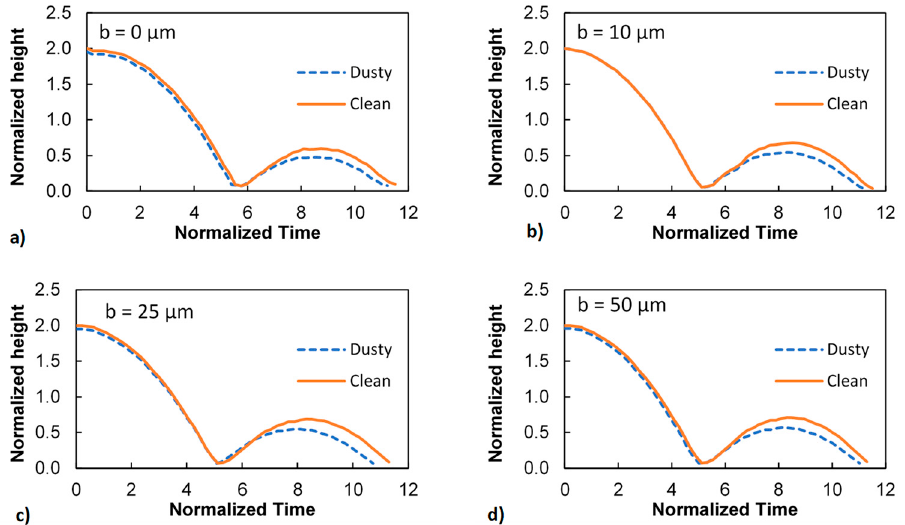
Figure 15. Variation of droplet normalized height with normalized time for impacting droplet on clean and dusty surfaces for various micro-post spacings: ( a ) flat hydrophobized surface b = 0 µ m,